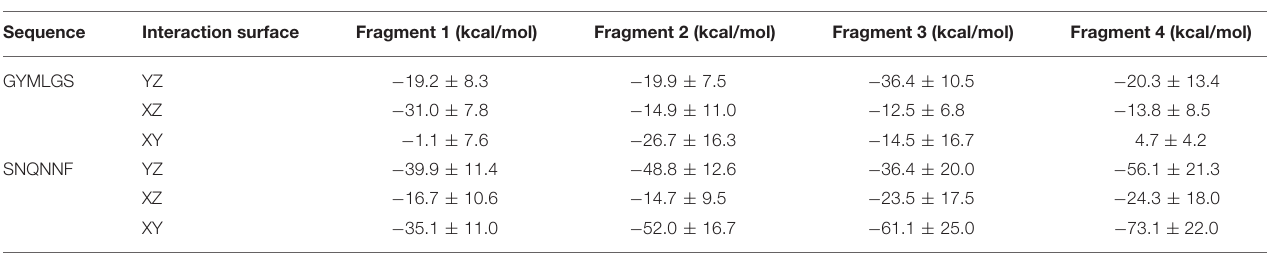
TABLE 2 | 3-dimensional energetics of the amyloid-RNA structures.